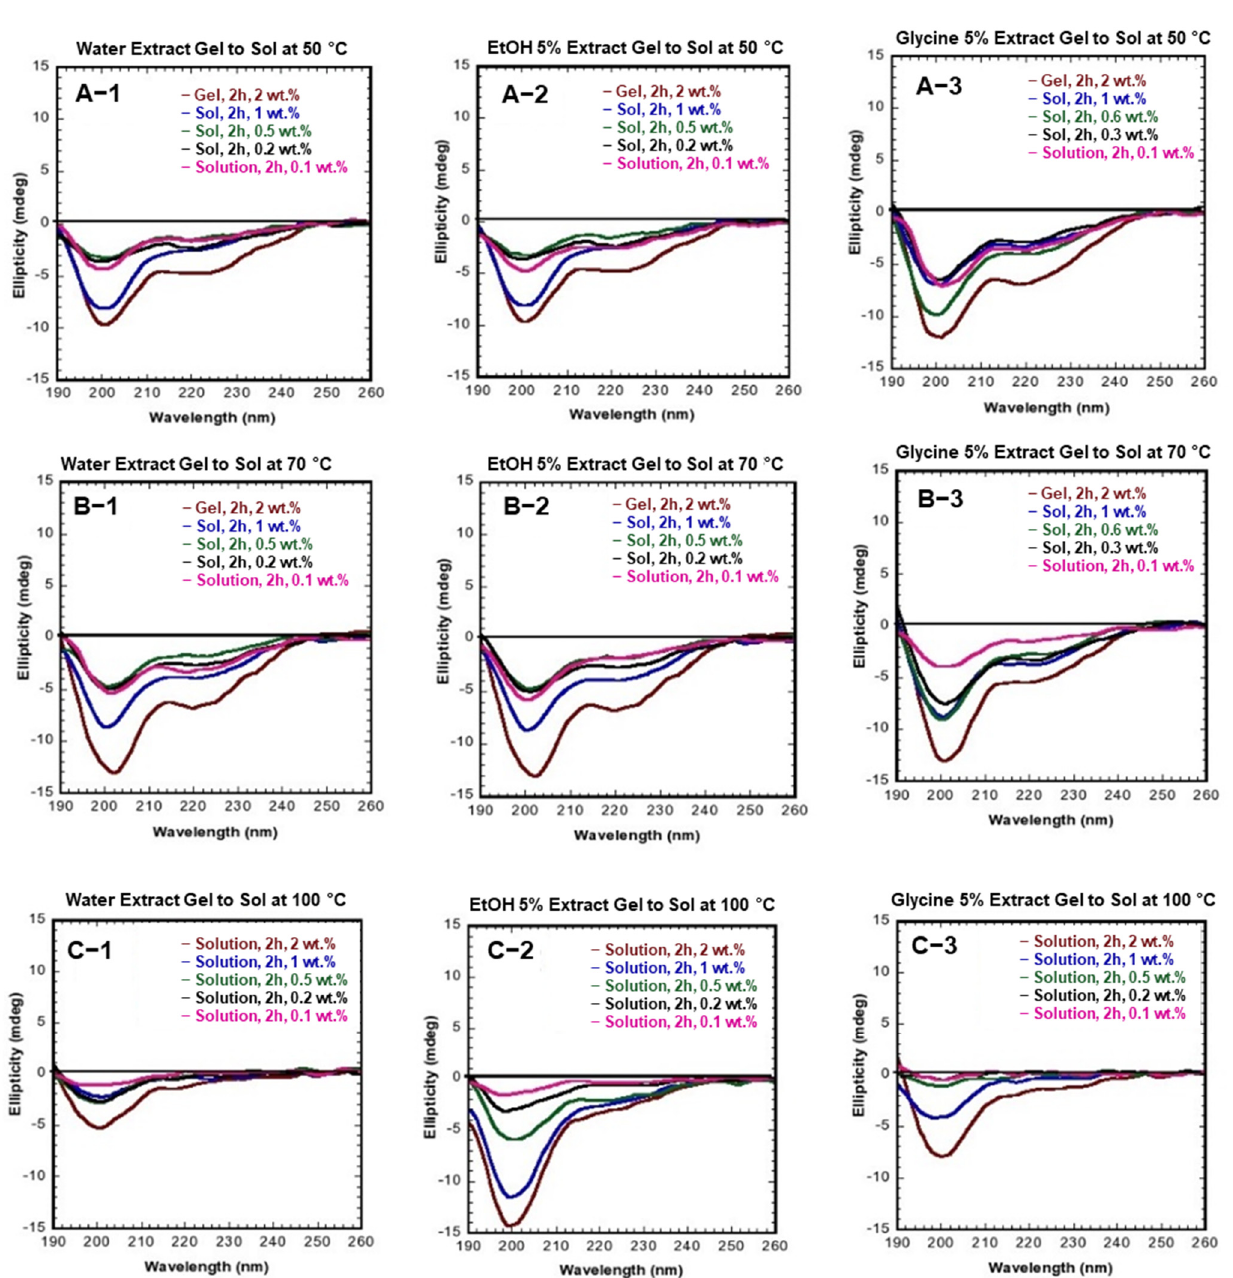
◦ C, 2 h; ( B-1 – B-3 ) at 70 ◦ C,